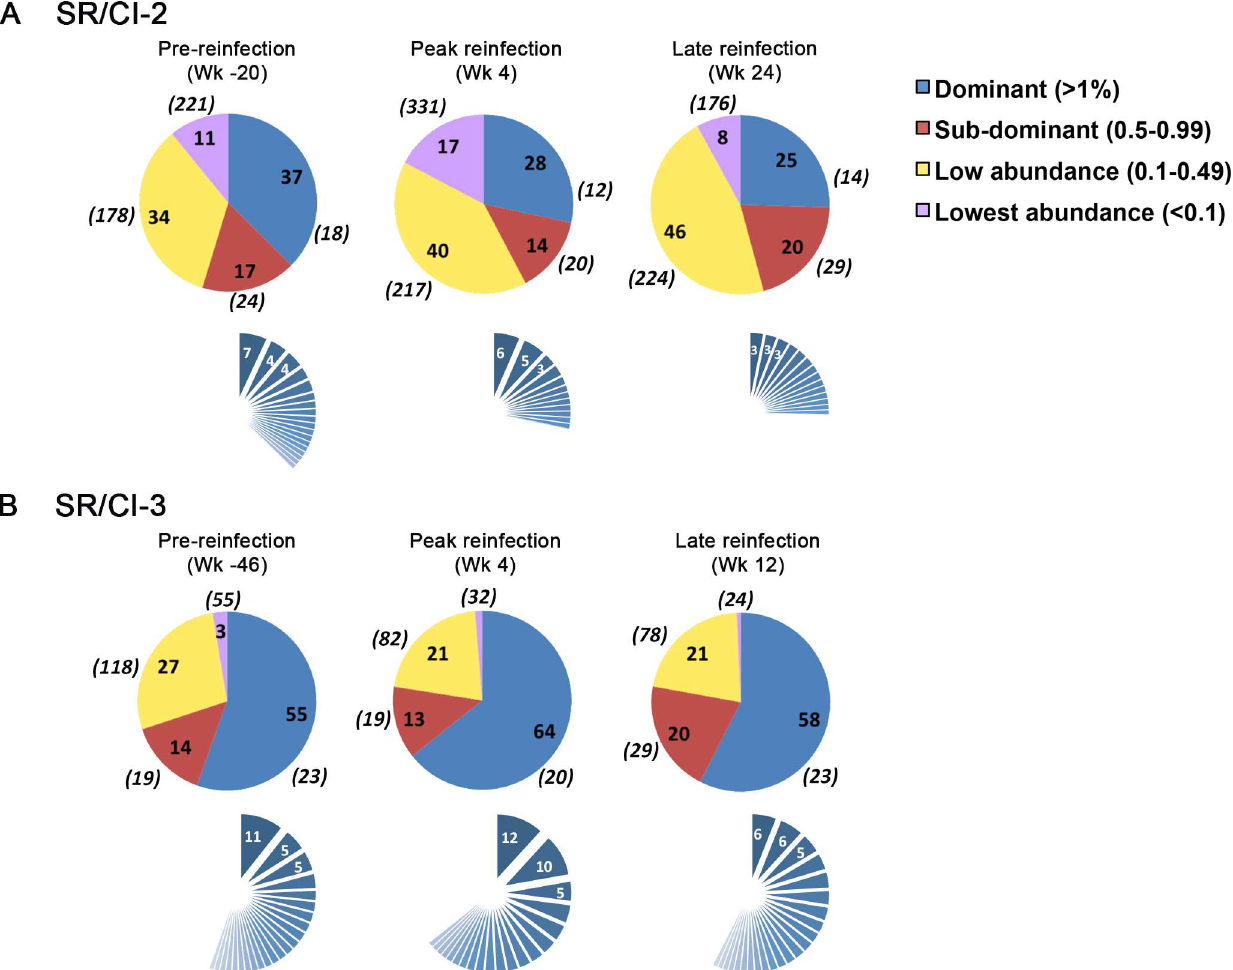
Fig 3. Highly diverse epitope-specific CD8 T cell repertoire in SR/CI patients. Pie charts showingthe distribution of the different categories of clonotypesforming the epitope-specific CD8 T cell repertoireat pre-, peak and late during the reinfectionepisodein patient SR/CI-2 (A) and SR/CI-3 (B). The pie charts in the upper rows show the percentage of each category (dominant, sub-dominant, low-abundance and lowest abundance clonotypesin blue, red, yellow and violet, respectively)with respect to the total clonotypes. The percentages of each category are representedby numbersinside the pie. The numbers betweenbrackets aroundthe pie charts represent the number of uniqueclonotypes forming each category. The sliced pie charts in blue in the lower rows represent the dissection of the individualclonotypesforming the dominant category, with the frequencyof the three most dominant clonotypesindicatedin white inside the corresponding slice.